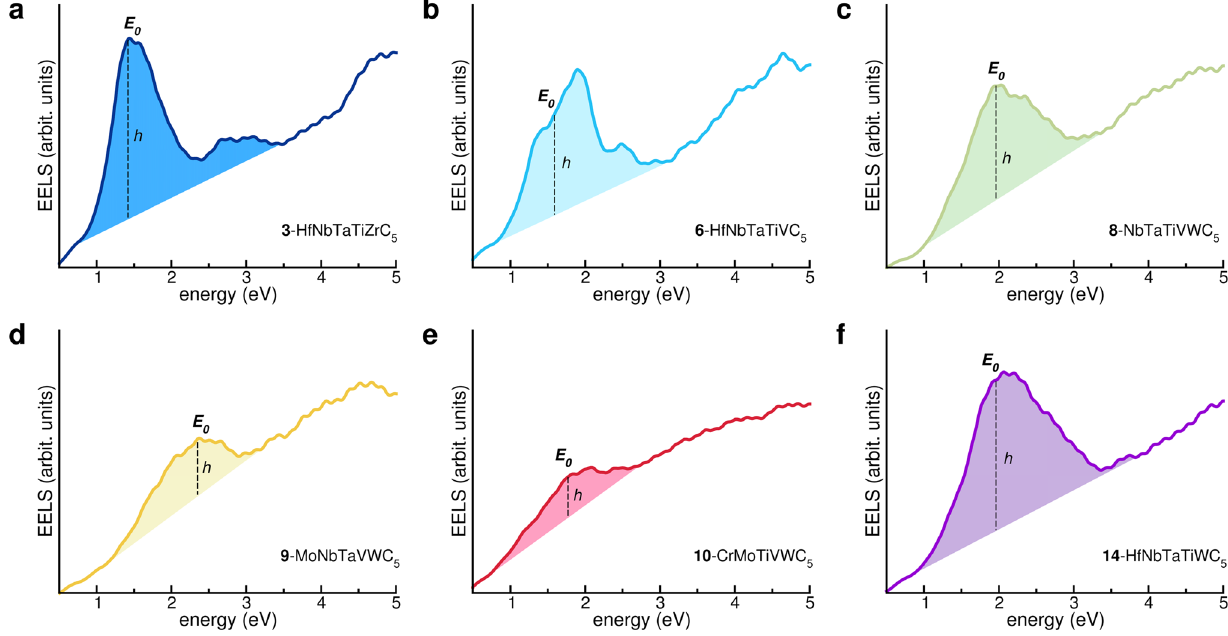
e 10 -CrMoTiVWC 5 . f 14 -HfNbTaTiWC 5 . Source data are provided as a Source Data fi